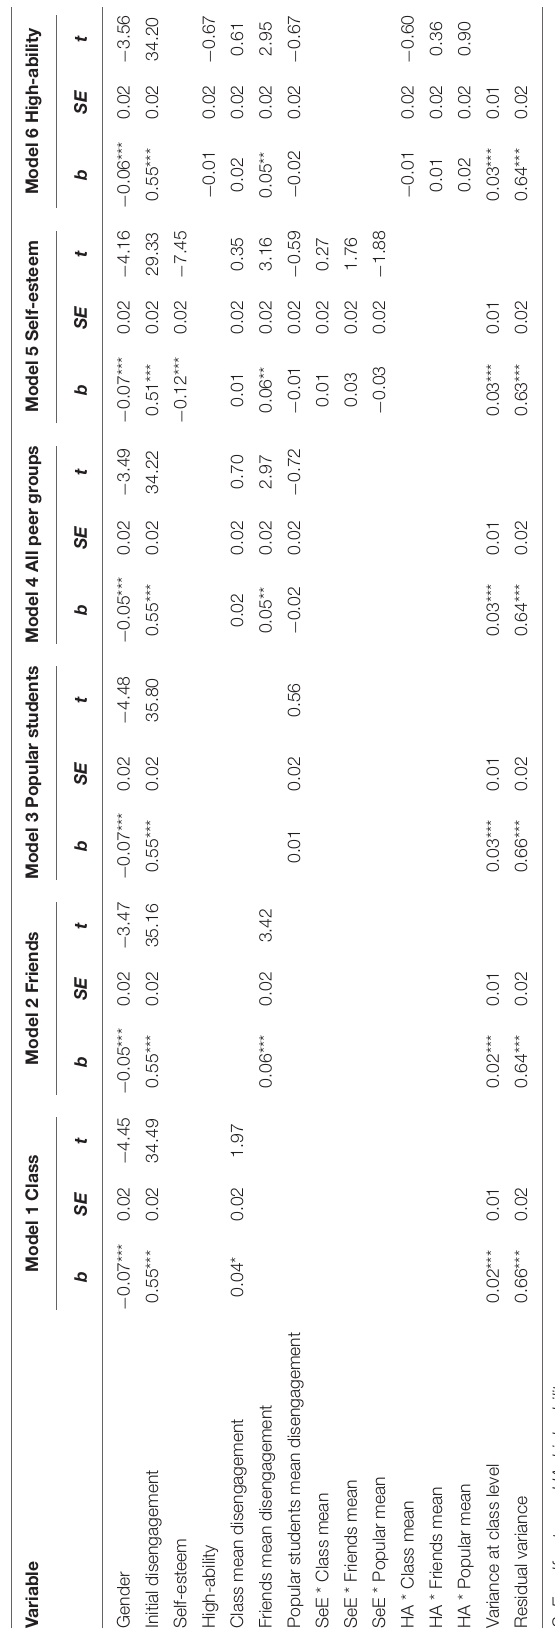
FIGURE 1 | Interaction effect between the average emotional engagement of friends and IQ on emotional engagement.